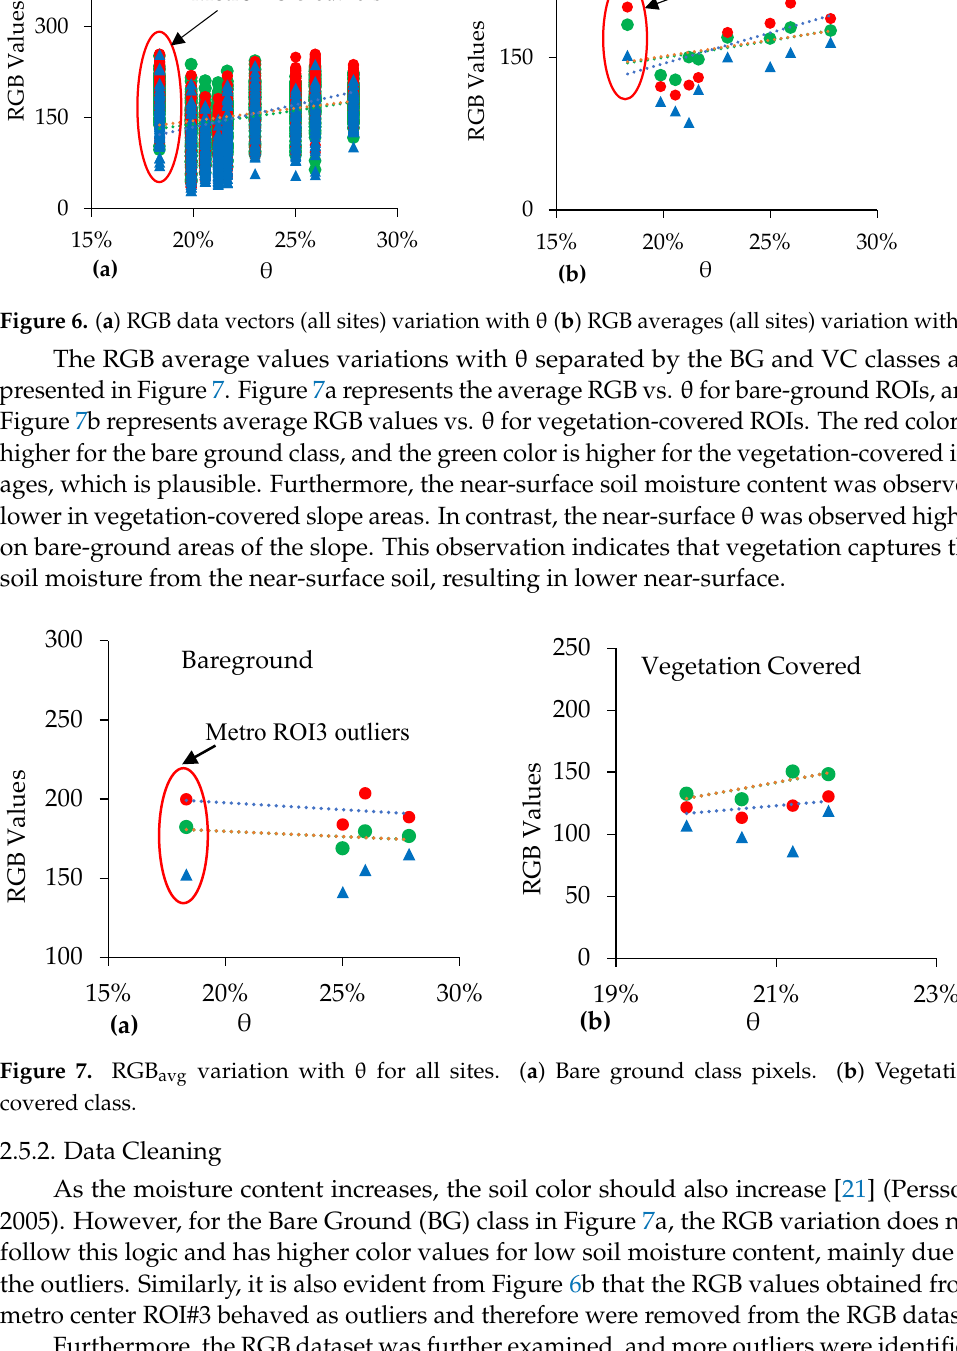
values are also presented in Table 2.